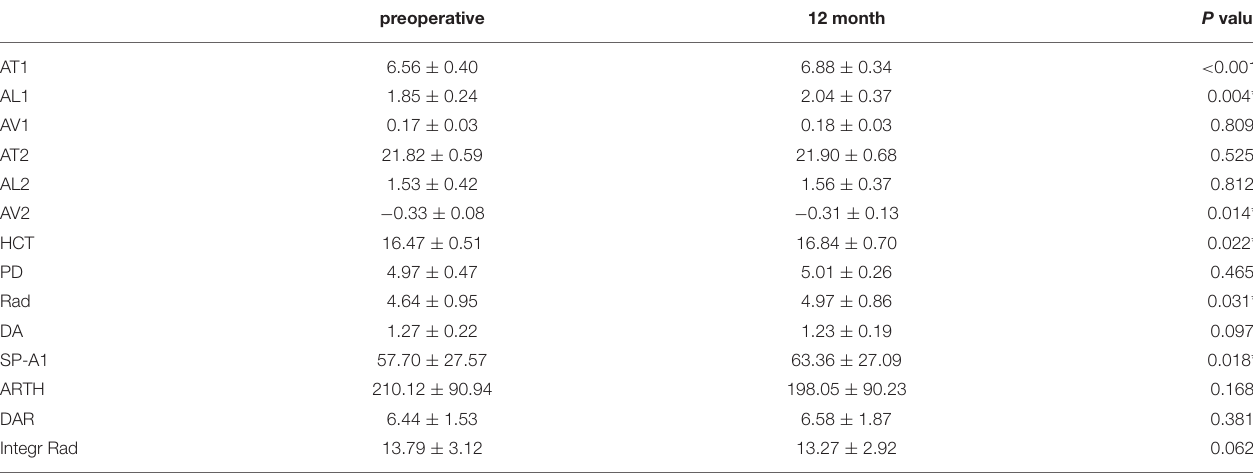
TABLE 3 | Pre-operative and post-operative parameters of Corvis ST (Mean ±